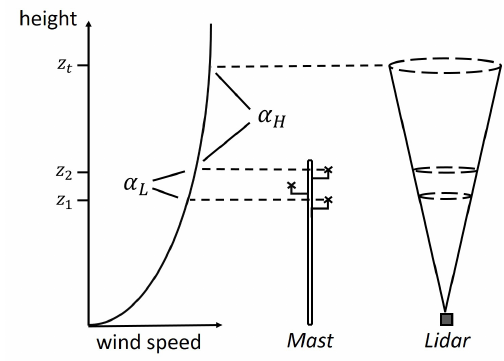
Figure 1. (Theoretical) measurement setup and power law exponents α L in the height range of the mast (i.e., between z 1 and z 2 ) and α H between mast top and target height ( z 2 and z t ),